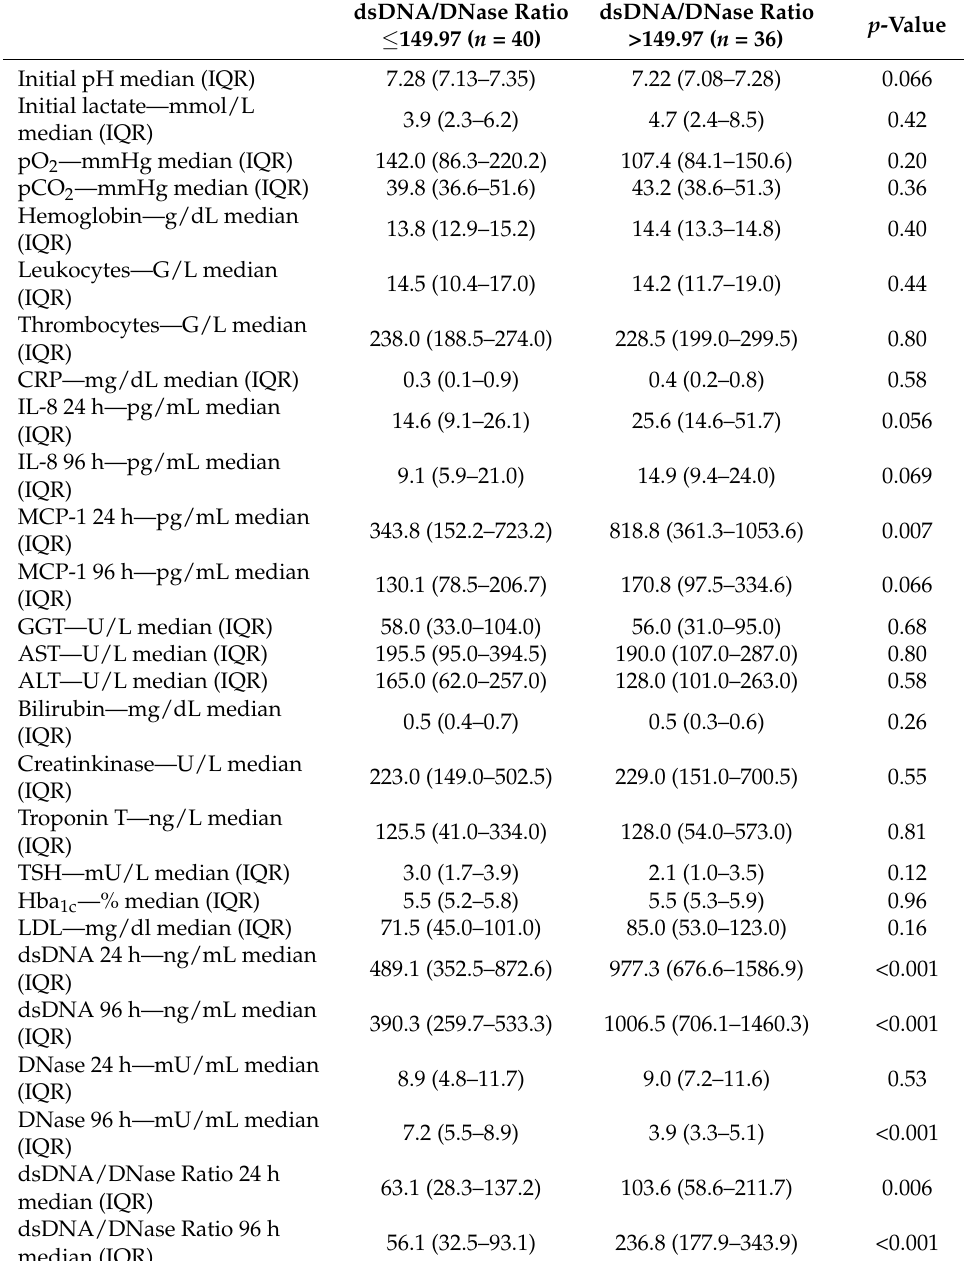
Table 4. Laboratory data according to dsDNA/DNase ratio below and above the empirical cut-off